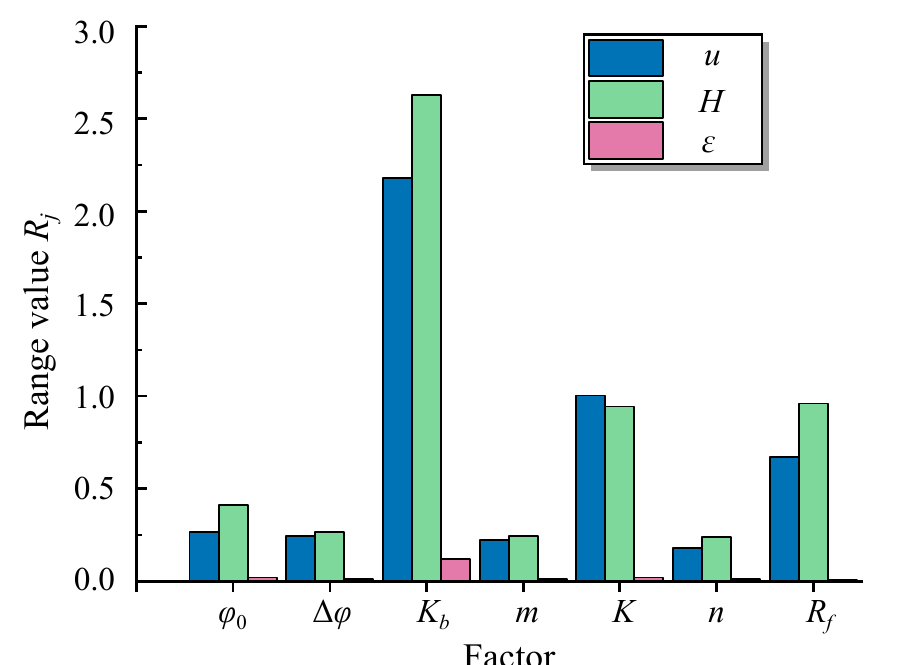
Figure 9. Sensitivity of each test index for the secondary rockfill zone. As shown in Table 9 and Figure 9, during the impoundment period, the sensitivity degree of maximum vertical displacement of dam u to indexes of secondary rockfill zone